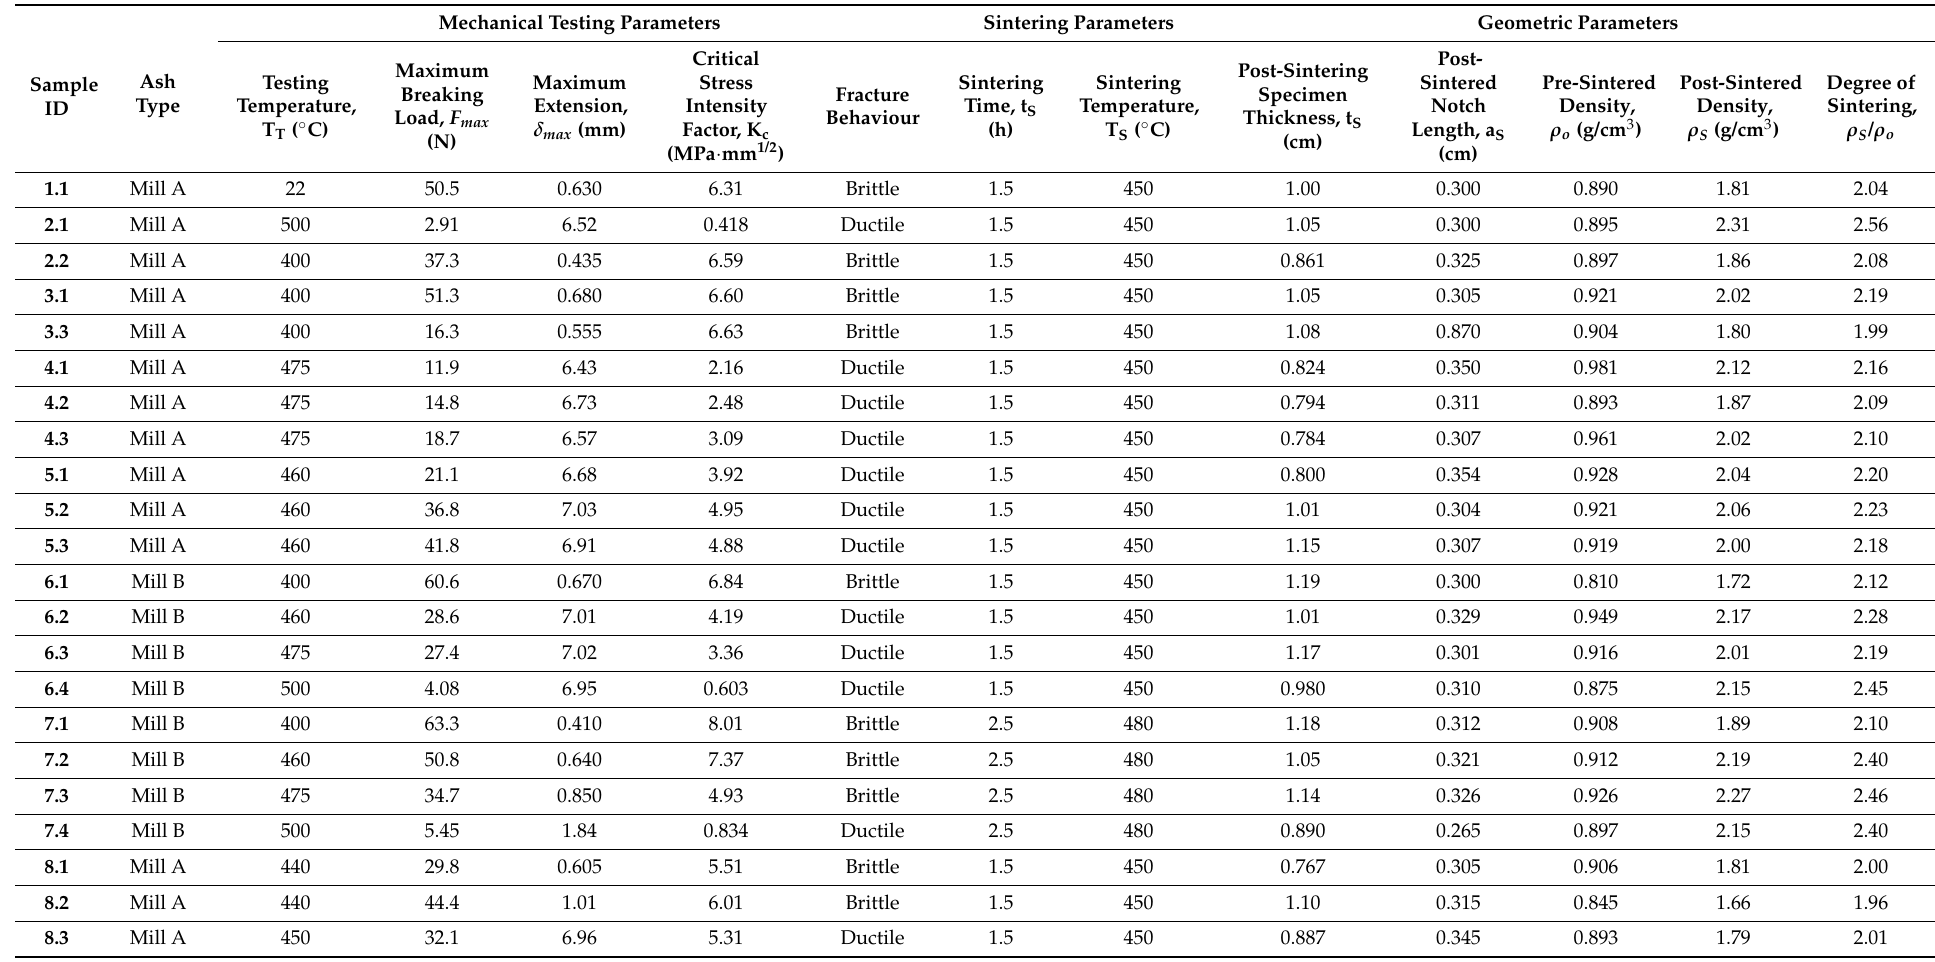
Table A1. Mechanical Testing and Sintering